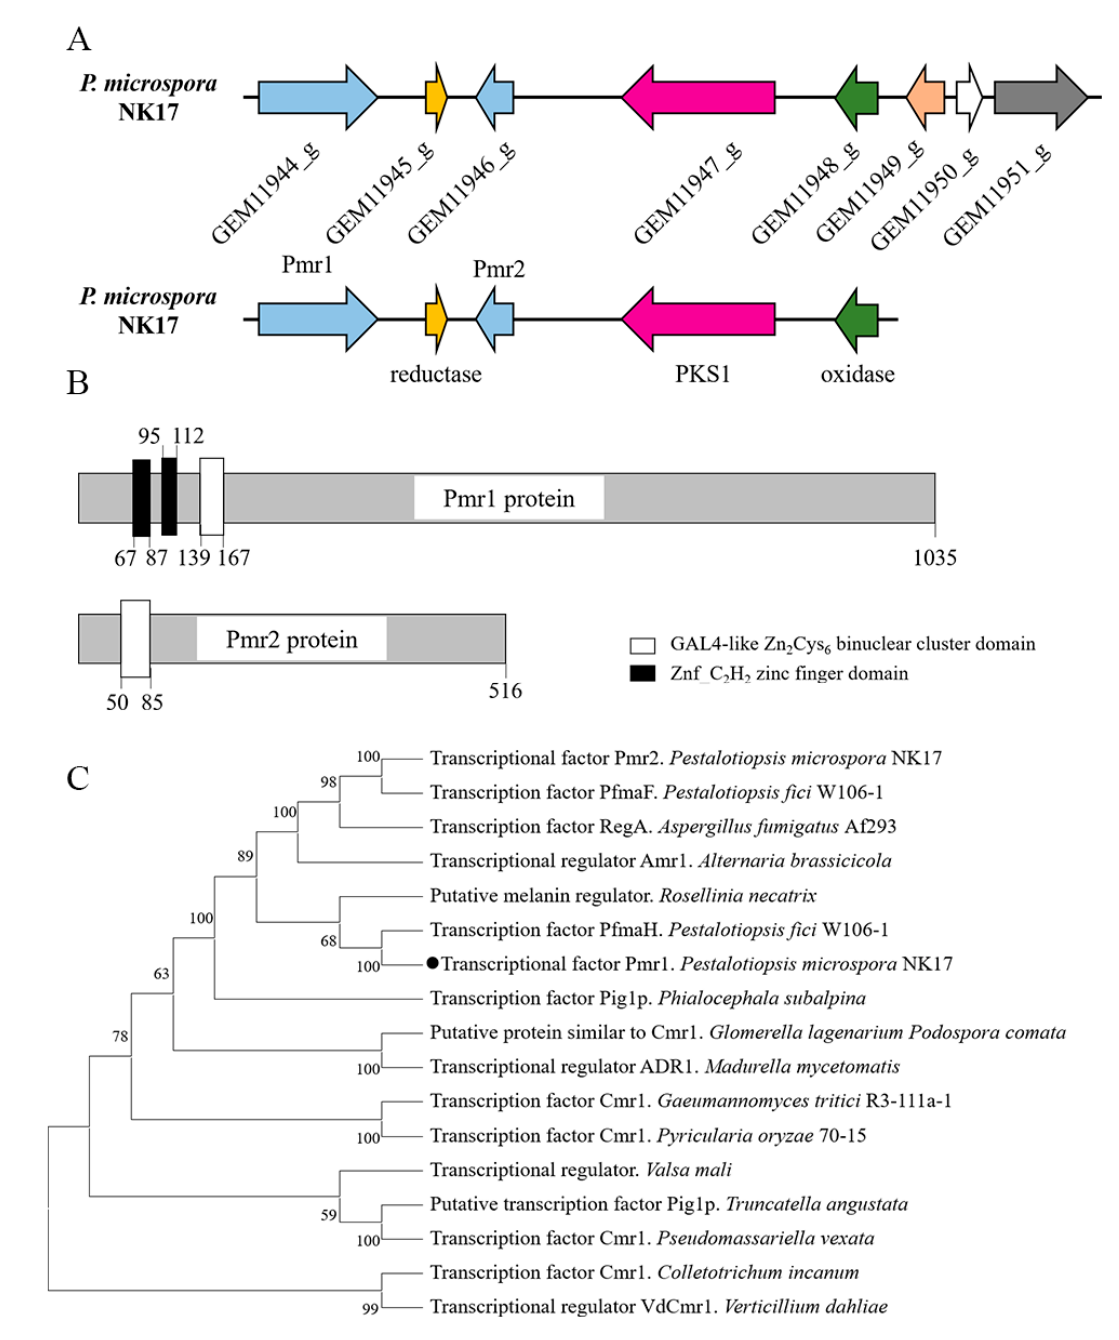
Figure 1. Structure of the pks1 gene cluster for melanin biosynthesis and prediction of TFs in the cluster. ( A ) The pks1 gene cluster includes eight genes, encoding oxidases, PKS, transcriptional factors and reductases that are remarkably conserved in P. microspora and other studied fungi. ( B ) Schematic of the domain architecture of TF Pmr1 and Pmr2. ( C ) Phylogenetic tree of Pmr1 was built with the neighbor-joining method by MEGA 11. Bootstrap supports >50% from 1000 replicates per run are labeled on branch nodes. TF Pmr1 of P. microspora is marked with a black